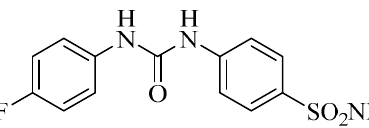
Figure 4. Structure of SLC-0111 (WBI-5111), the sulfonamide CA IX/XII inhibitor in Phase I/II clinical trials.